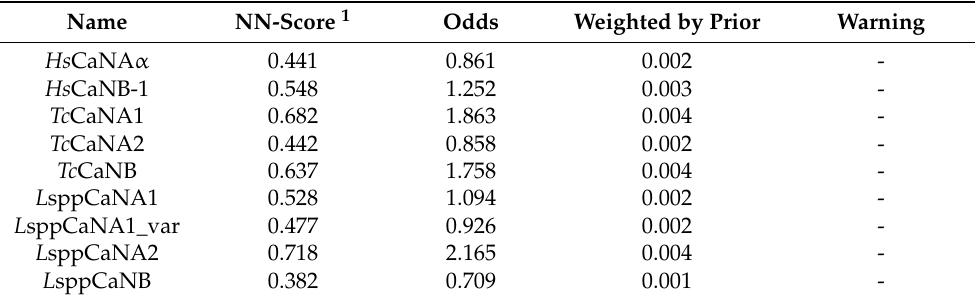
Table 4. SecretomeP 1. of predictions of CaNAs and CaNBs. Non-classically secreted proteins should obtain an NN-score/SecP score exceeding the threshold, but should not at the same time be predicted to contain a signal